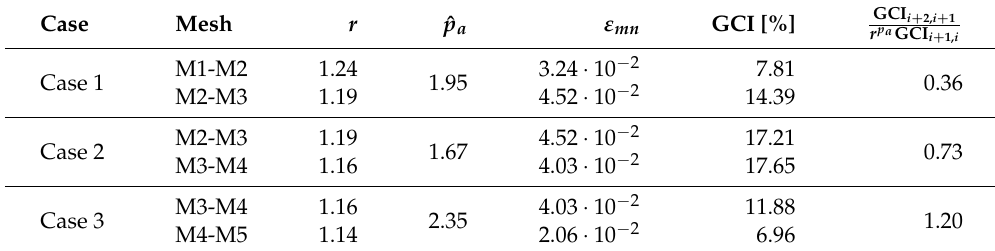
Table 2. Overview of GCI analysis for the baffled shake flask at a shaking rate of 130rpm and shaking amplitude of 50mm. The number of mesh cells corresponds to n c , the volume-averaged Kol- mogorov length scale to λ k , the mesh refinement factor to r , the observed order of accuracy to ˆ p a , and the relative error to ε mn . M1: n c = 0.28 · 10 6 cells, λ k = 6.906 · 10 − 5 m; M2: n c = 0.54 · 10 6